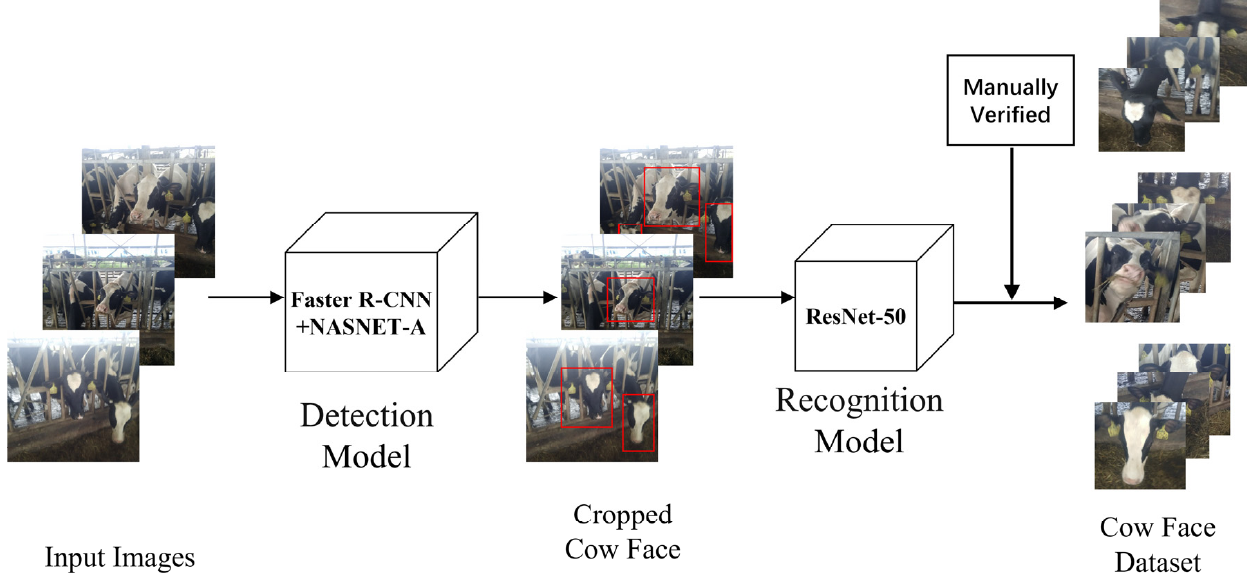
Figure 1. Generation process of cow face dataset.